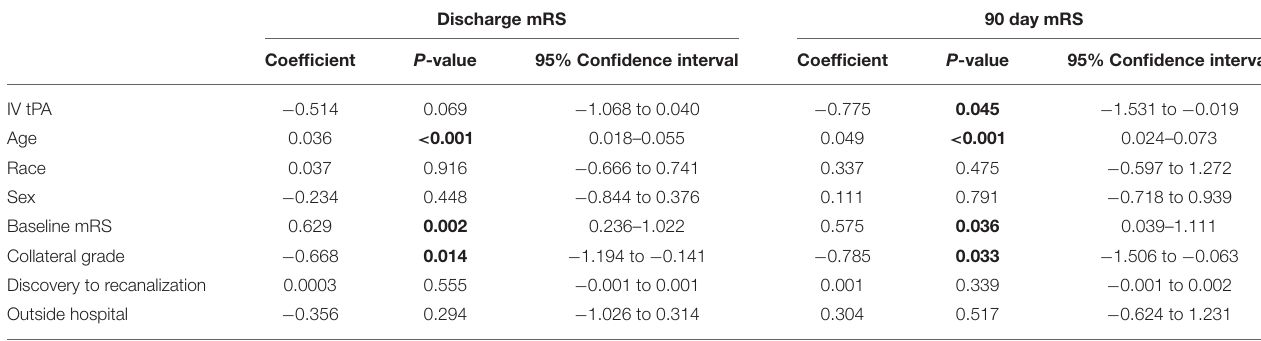
TABLE 3 | Multivariable regression of discharge and 90 day post-stroke